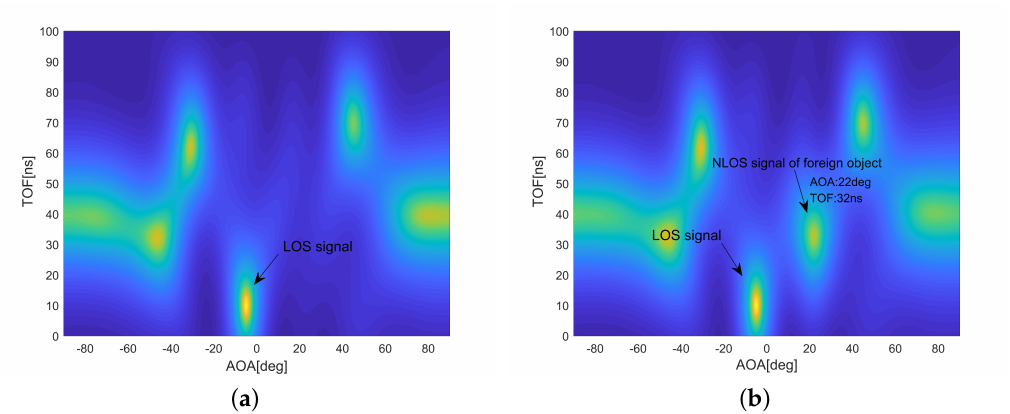
Figure 11. Visualization results of foreign object detection. ( a ) Without foreign object. ( b ) With foreign object.